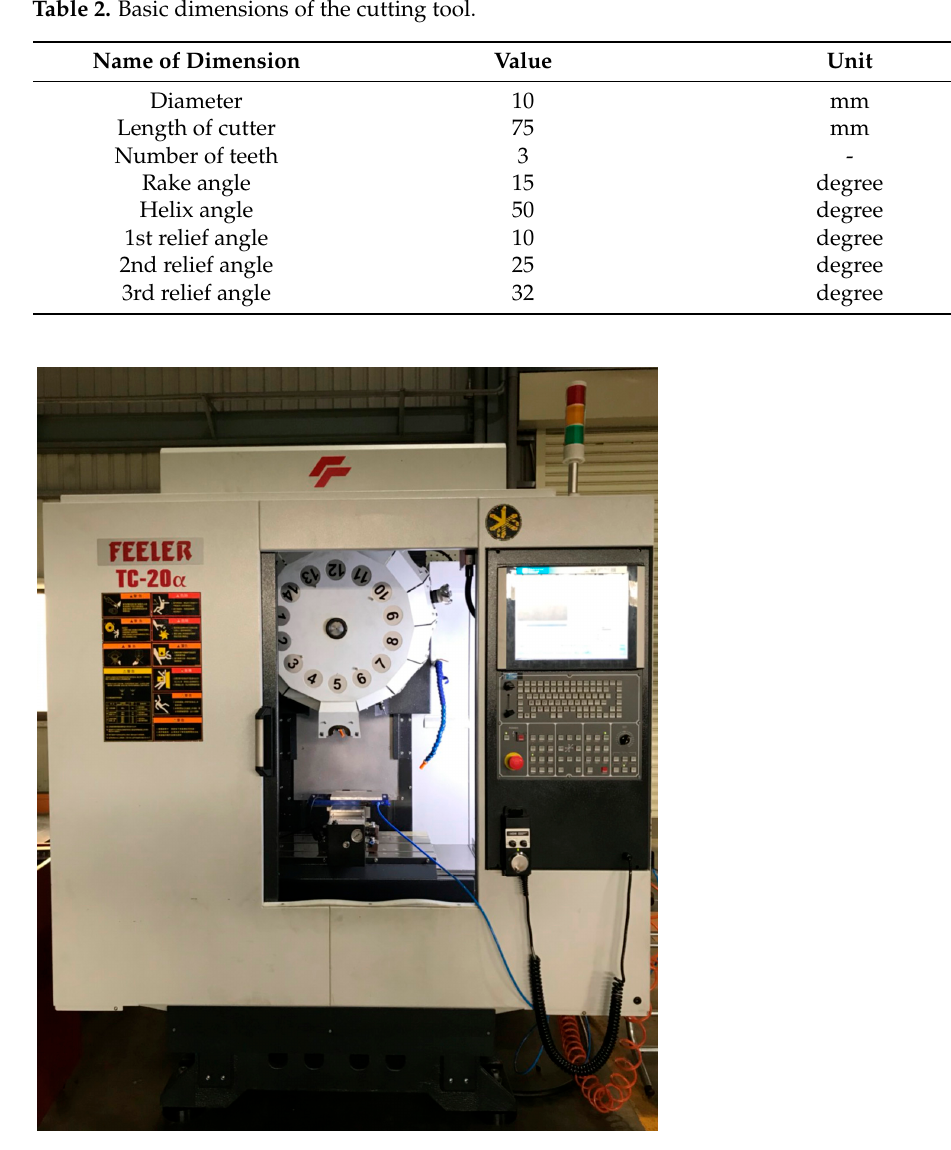
Figure 1. The FFG model TC-20 α machining center.